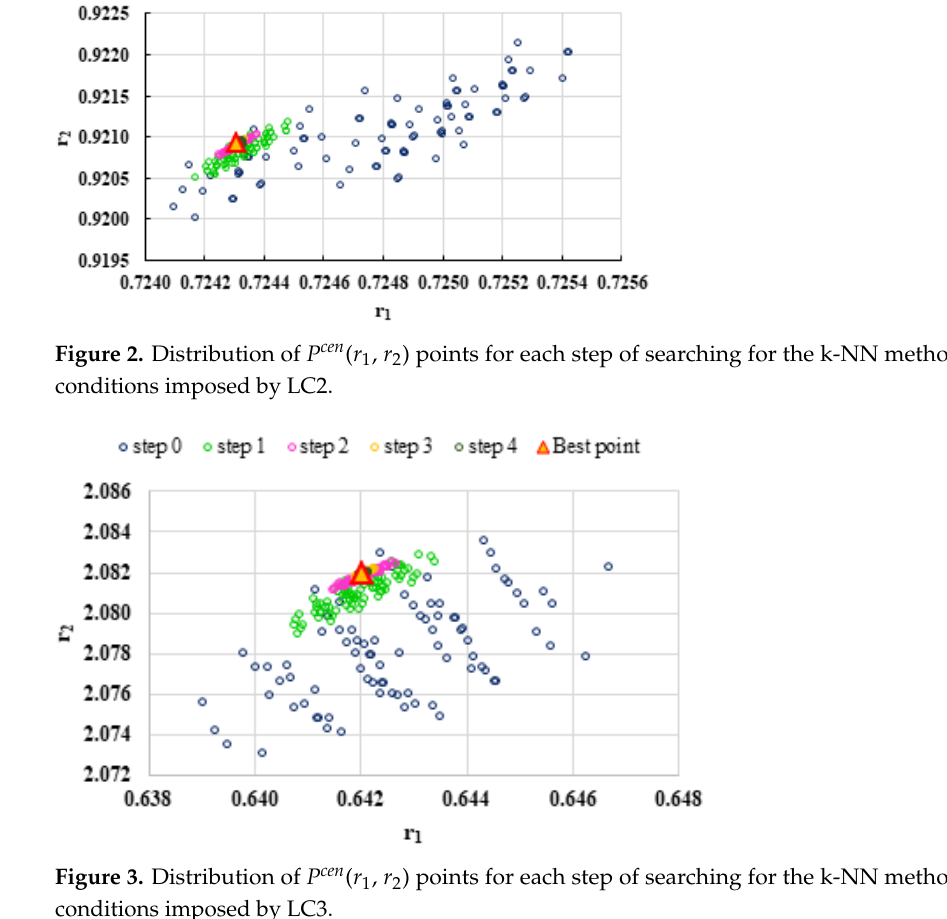
Figure 1. Distribution of P cen (r 1 , r 2 ) points for each step of searching for the k-NN method for the conditions imposed by LC1.